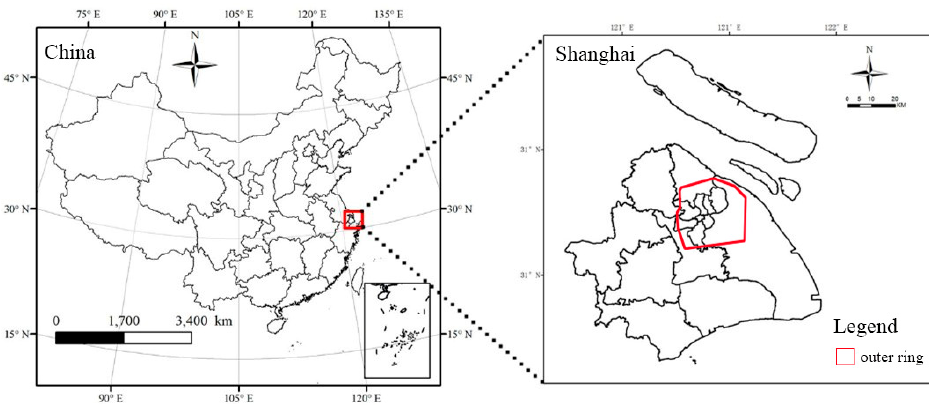
Figure 1. Location of Shanghai, China.